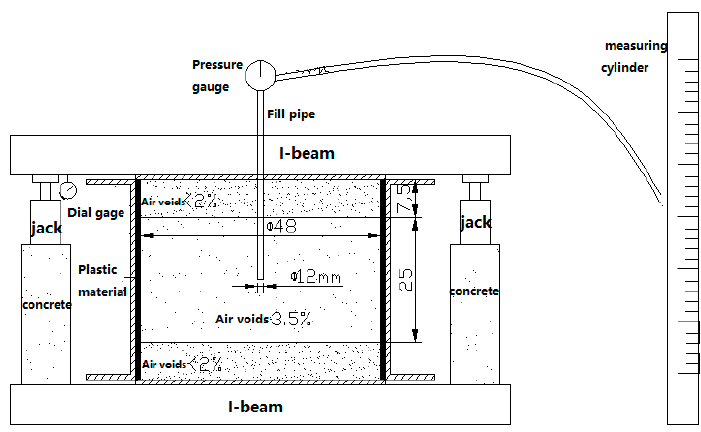
Figure 1. Model device of hydraulic fracture feasibility test.